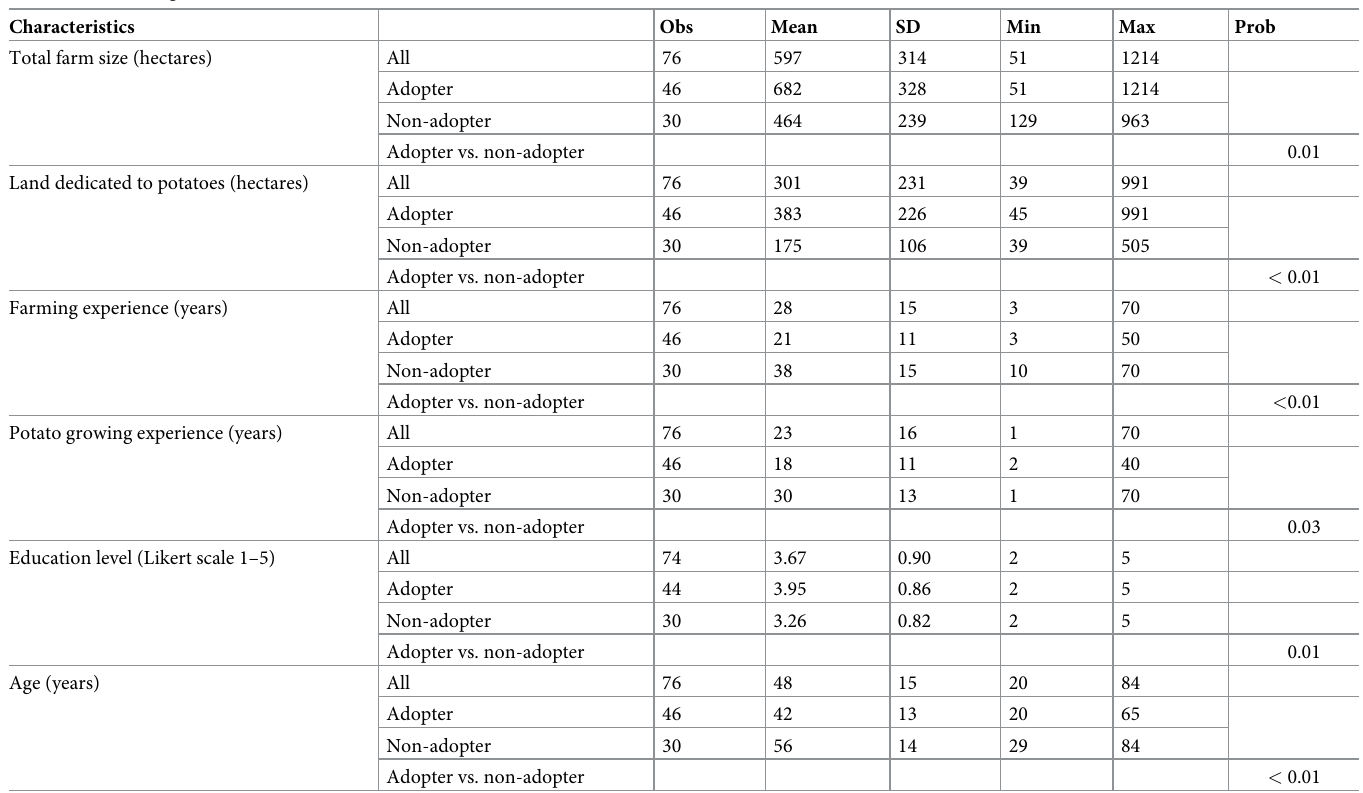
Table 3. Farm and grower